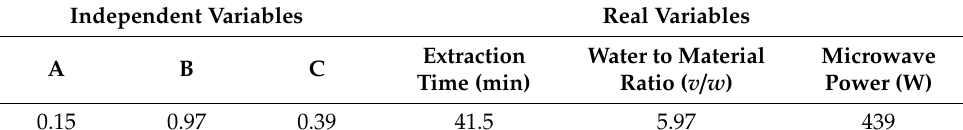
Table 4. The values of the independent variables and real variables.